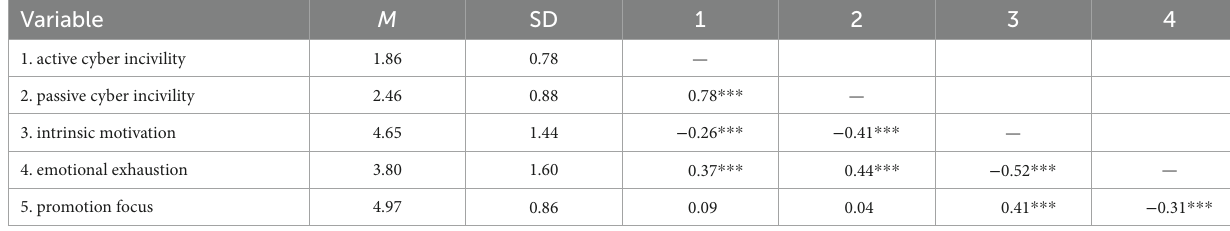
TABLE 3 Descriptive statistics and correlations among Study 2 variables.